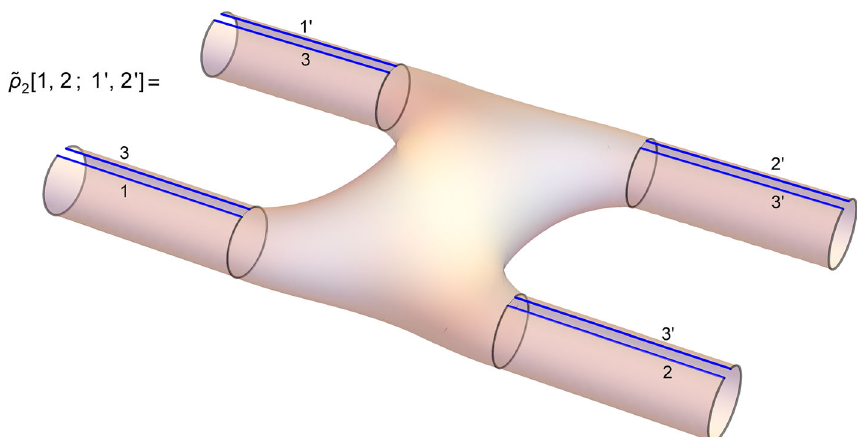
Fig. 19 Geometric representation of the ˜ ρ 2 reduced density matrix associated with the replicated connected manifold. This geometry can be regarded as a complex wormhole connecting the